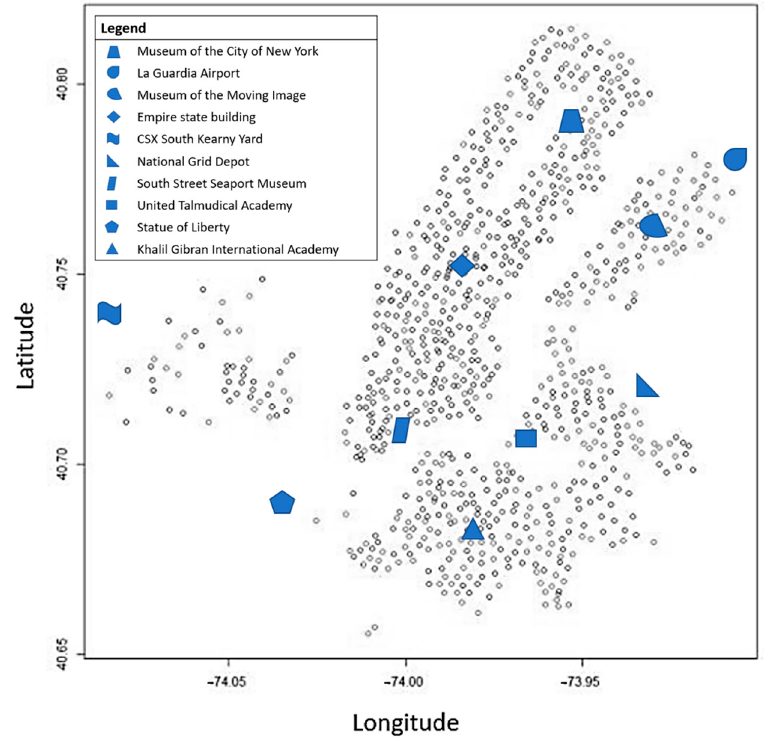
Figure 1. Citi Bike New York bike stations map reconstructed.